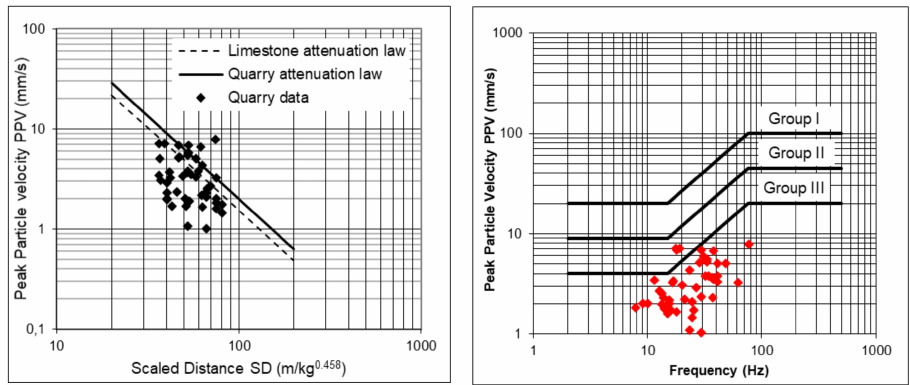
Figure 7. Representation of the general law according to the case study data from 2006 and Balsa [25].